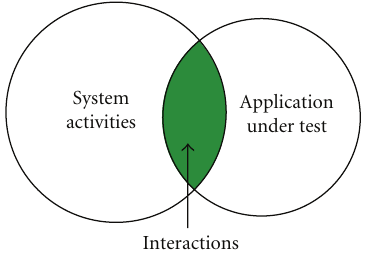
Figure 7: Interactions between the design under test and the host system correspond to the activities emulated by the mock object.